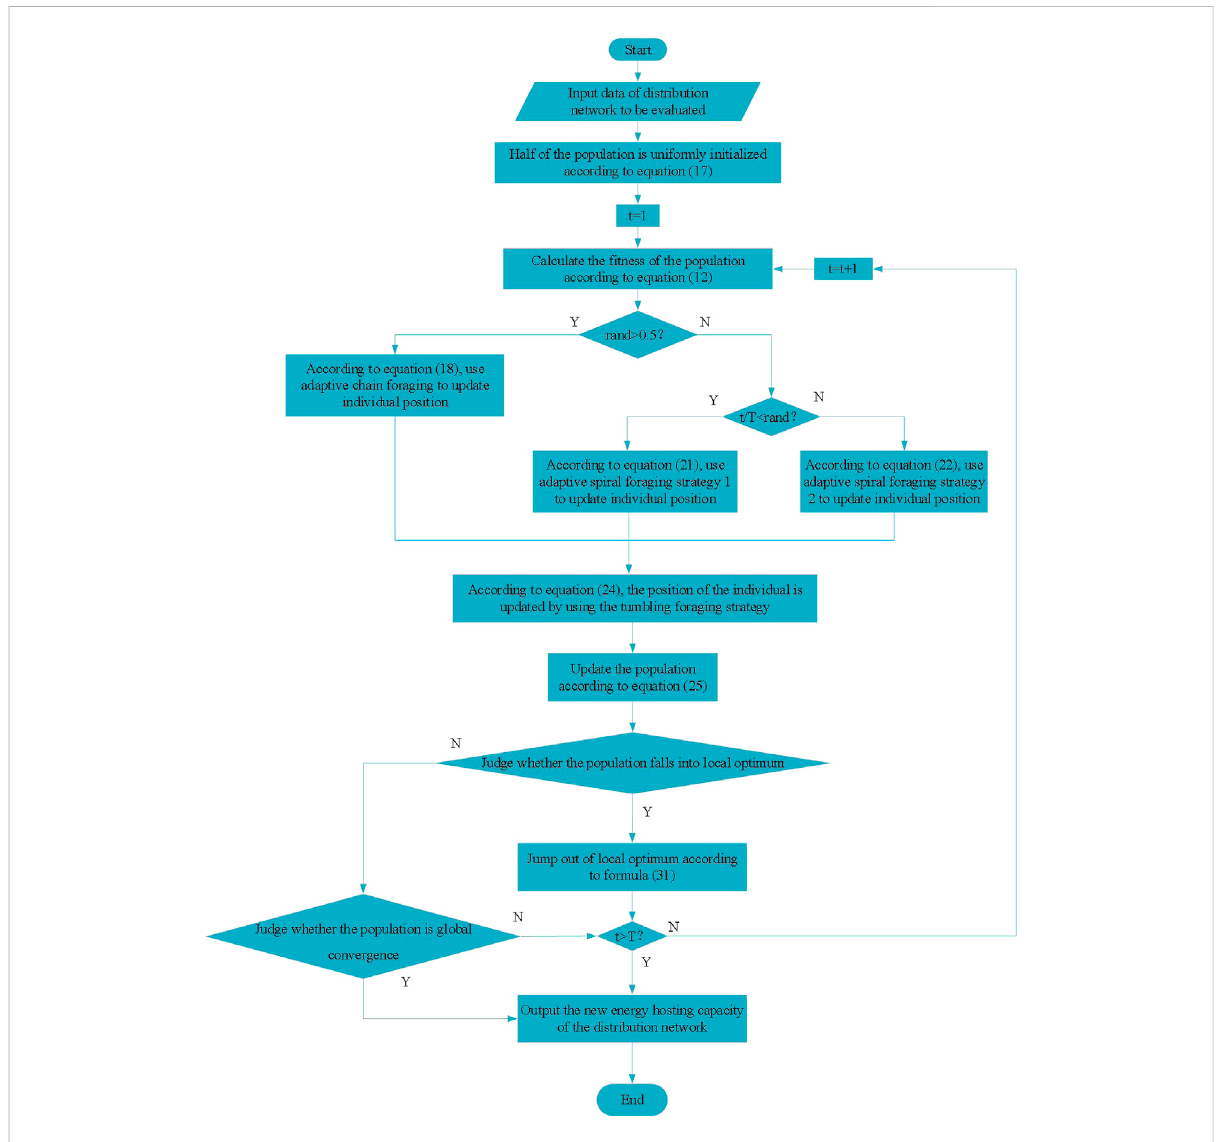
FIGURE 3 MSAMRFO solution